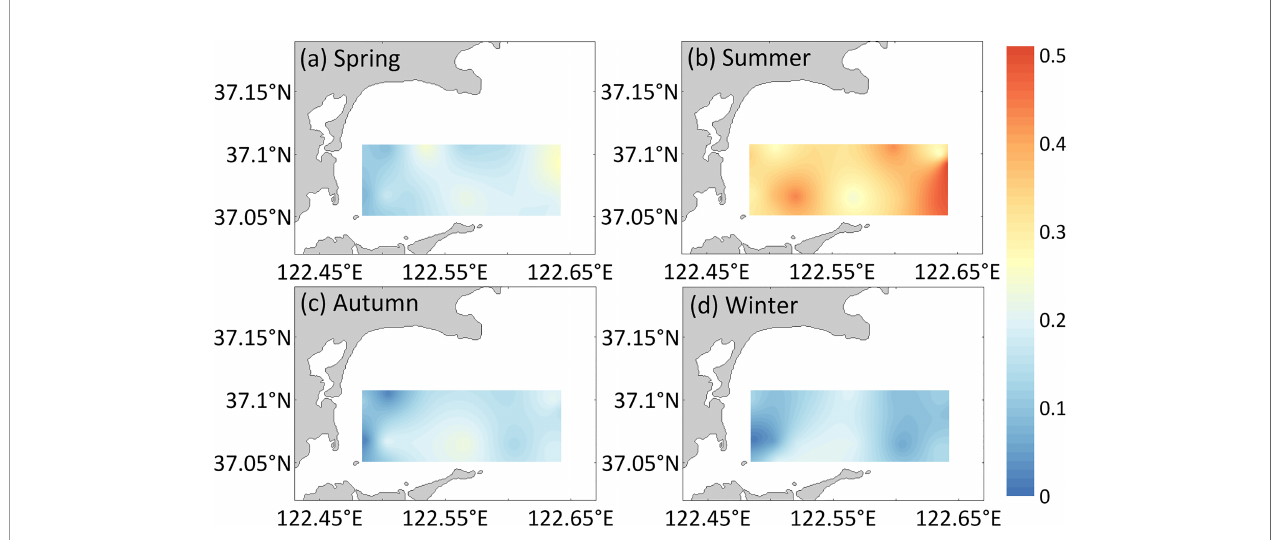
FIGURE 5 | Horizontal distribution of POC (mg/L) for the (A) spring, (B) summer, (C) autumn, (D) winter surface water in Sanggou